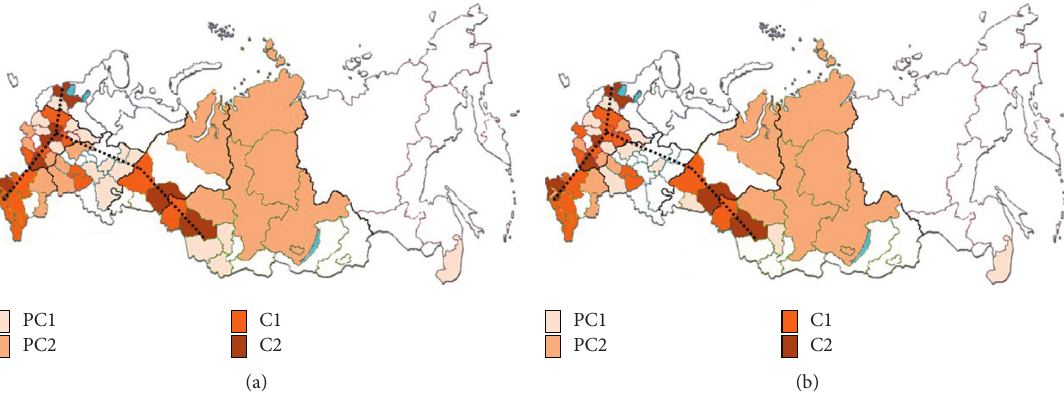
Figure 1: Allocation of the Russian Federation regions on the indicators: ( a ) registered drug user quantity; (b) quantity of registered crimes connected with drug